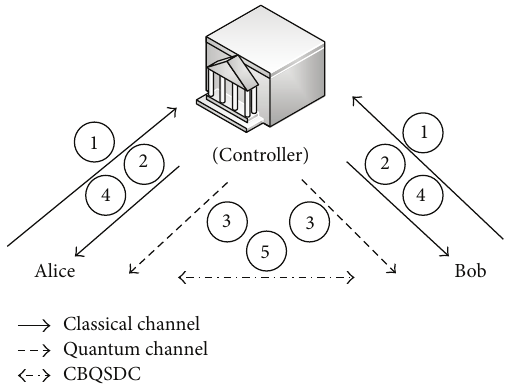
Figure 1: The demonstration of online